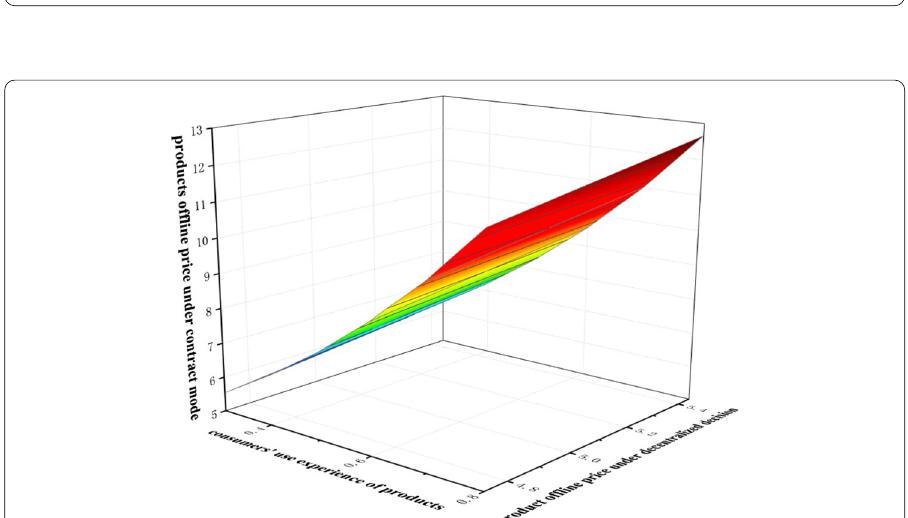
Fig. 2 Change of product online prices P 1 with consumer’s experience in using products